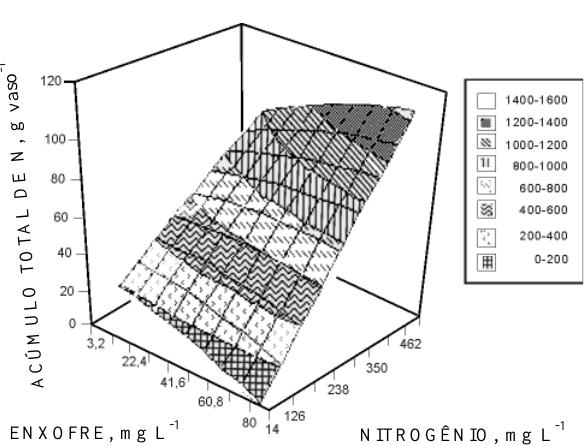
Figura 5. Concentração de nitrogênio nas raízes do capim-Marandu, considerando as combinações de doses de nitrogênio e de enxofre aos 79 dias do transplantio.